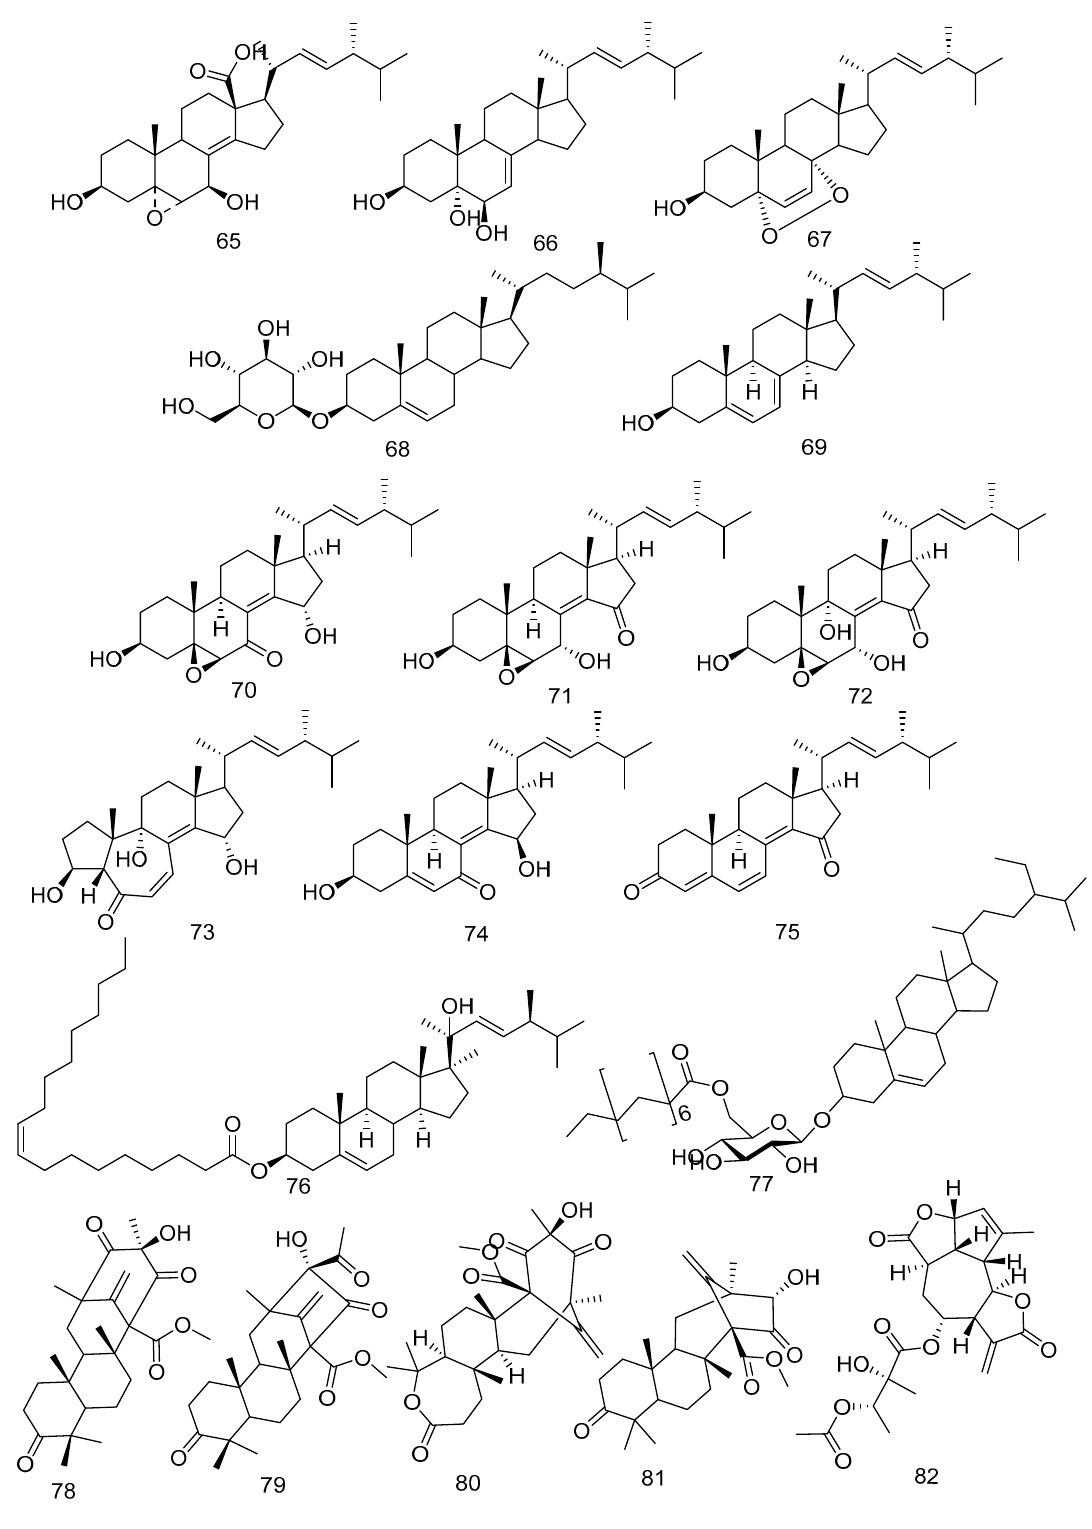
Figure 3. The steroid ( 65 – 77 ) and meroterpenoid ( 78 – 82 ) compounds were obtained from various fungi in Meliaceae Family.